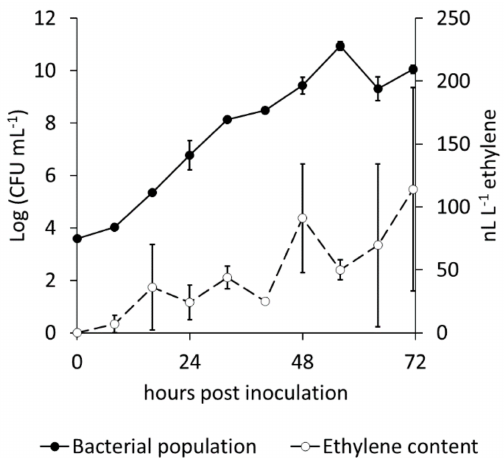
Figure 2. Comparative kinetics of population growth and ethylene release from Pseudomonas syringae pv. actinidiae . The strain CFBP7286 was grown in liquid culture. Values are presented as the average ± standard error ( n =